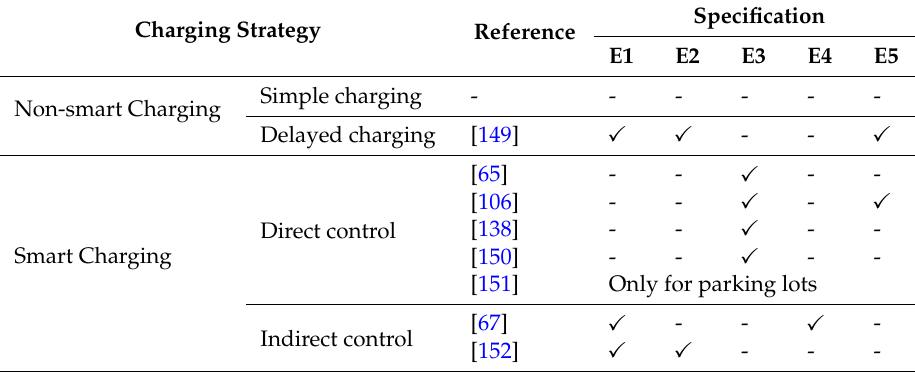
Table 4. Category of EV charging strategies with their specifications. Table 2. List of recent research on DSM. Table 2. List of recent research on DSM. Table 2. List of recent research on DSM. Table 2. List of recent research on DSM. Table 2. List of recent research on DSM. Table 2. List of recent research on DSM. Table 2. List of recent research on DSM. Table 2. List of recent research on DSM. Table 2. List of recent research on DSM. Table 2. List of recent research on DSM. Table 2. List of recent research on DSM. Table 2. List of recent research on